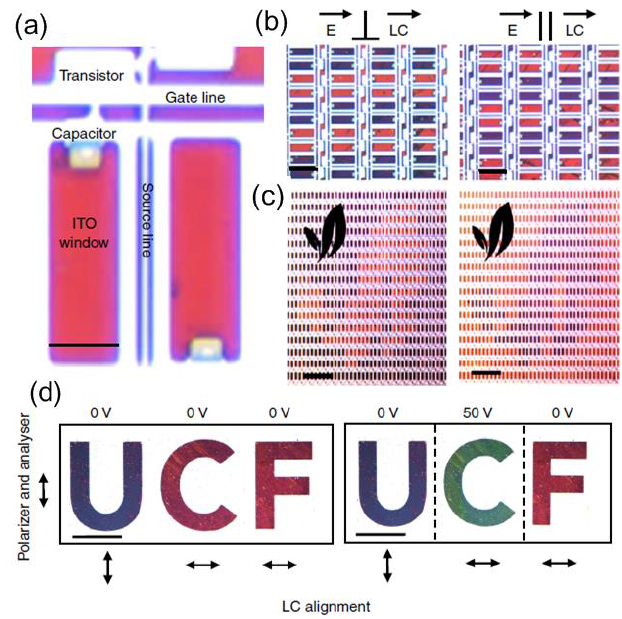
Figure 14. ( a ) Microscopic image of metasurfaces integrated with thin-film-transistor (TFT), and ( b ) shows that each row is opened every third and fourth rows in the case of parallel and vertical incident light for the top LCs orientation layer. ( c ) Arbitrary image displayed using a device photographed with a 4× objective. ( d ) Passive addressing devices with defined letters of “UCF” as a function of different parameters. Reproduced with permission from [120]. Copyright Macmillan Publishers Limited, 2017.